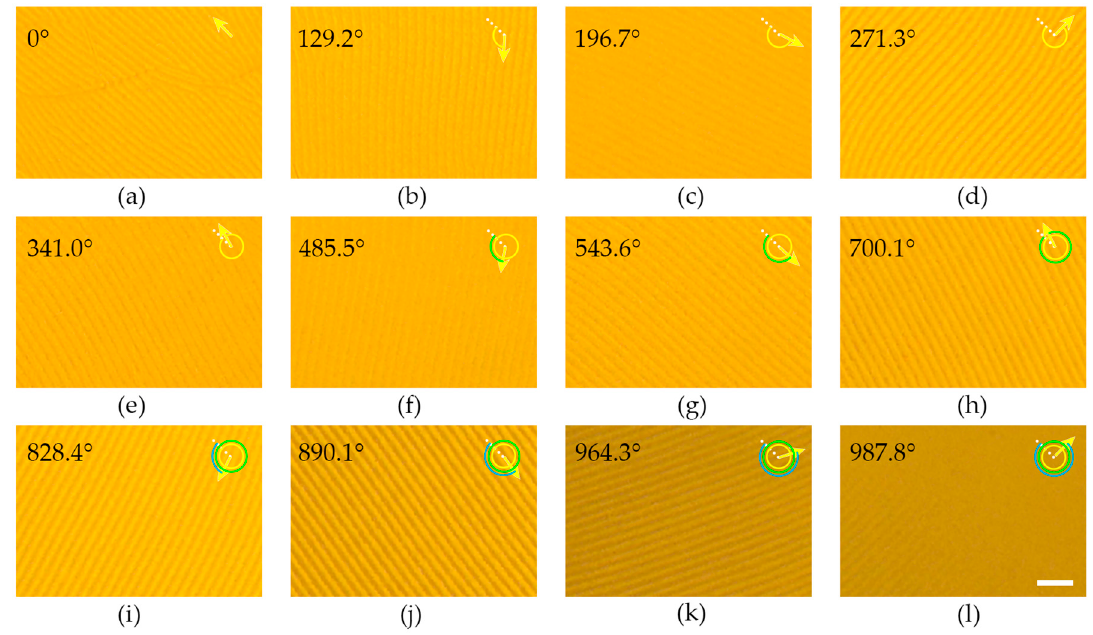
Figure 2. Light-driven rotation of the CLC grating (1 wt % ChAD-3c-S) along with the increasing exposure. The rotational angle is labeled in each top-left corner. The scale bar represents 25 μ m for all images.